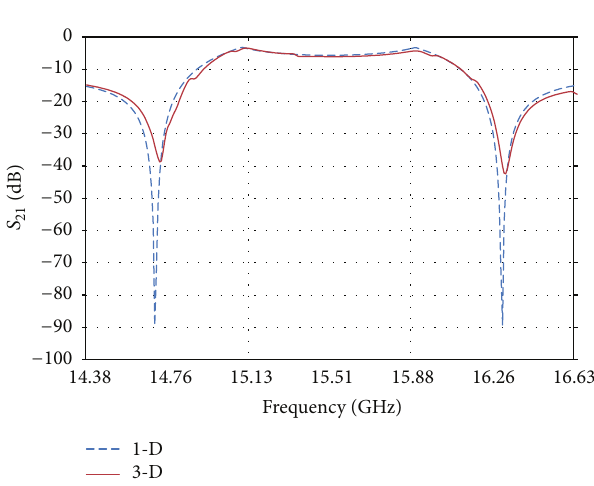
Figure 9: Comparison of FBAR filter transmission response ( 𝑆 21 ) between 1D and 3D